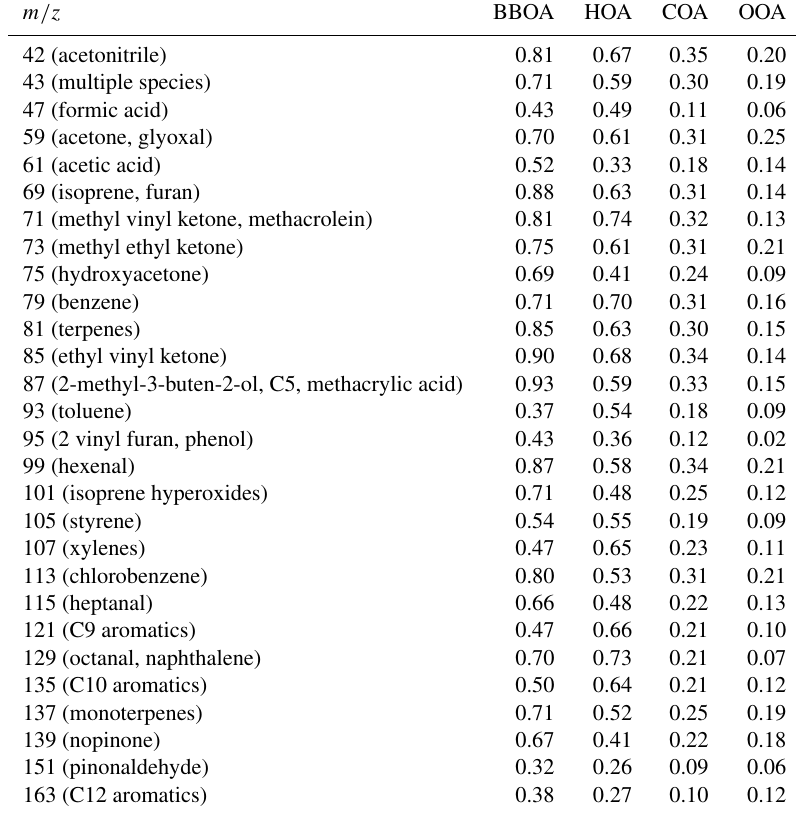
Table 1. Coefficient of determination R 2 between the OA factors in Athens and VOCs.